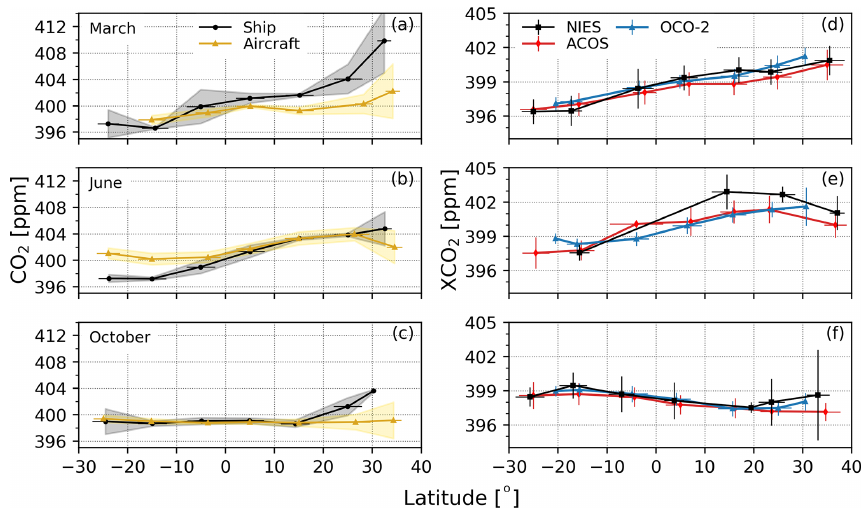
Figure 4. Latitudinal distribution of the CO 2 mixing ratio obtained by ship (black) and aircraft (yellow) (a, b, c) and of XCO 2 obtained by NIES (black), ACOS (red), and OCO-2 (blue) (d, e, f) for three selected months in 2015, which are representative of different latitudinal CO 2 gradients in the troposphere: March (a, d) , June (b, e) , and October (c, f) . Shaded areas are the standard deviation of the monthly average CO 2 mixing ratios. Error bars show the standard deviation of the monthly averaged XCO 2 and of the location within each latitude box.